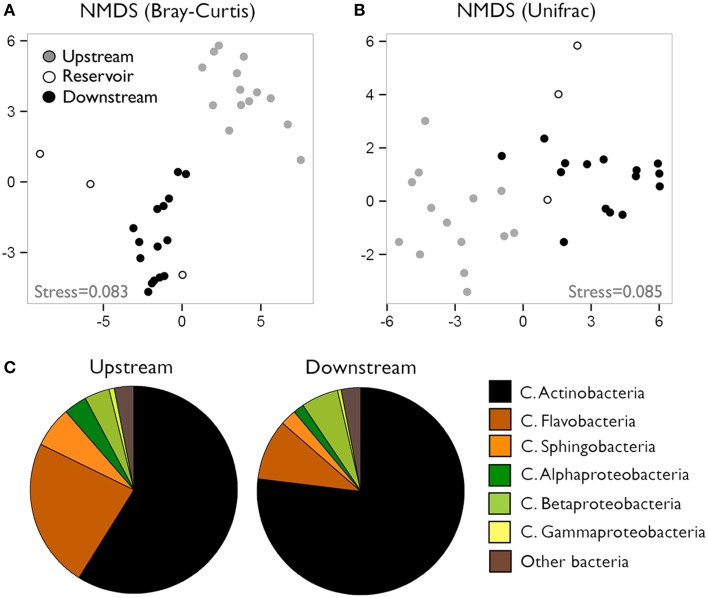
(A) Non-metric multidimensional scaling (NMDS) charts of community composition in the different river sections based on Bray-Curtis (A) and Weighted-Normalized Unifrac (B) distances. (C) Contribution of the different bacterial classes to community composition of upstream and downstream waters. Data presented as percent contribution of each group to total sequences (average of the three samplings).